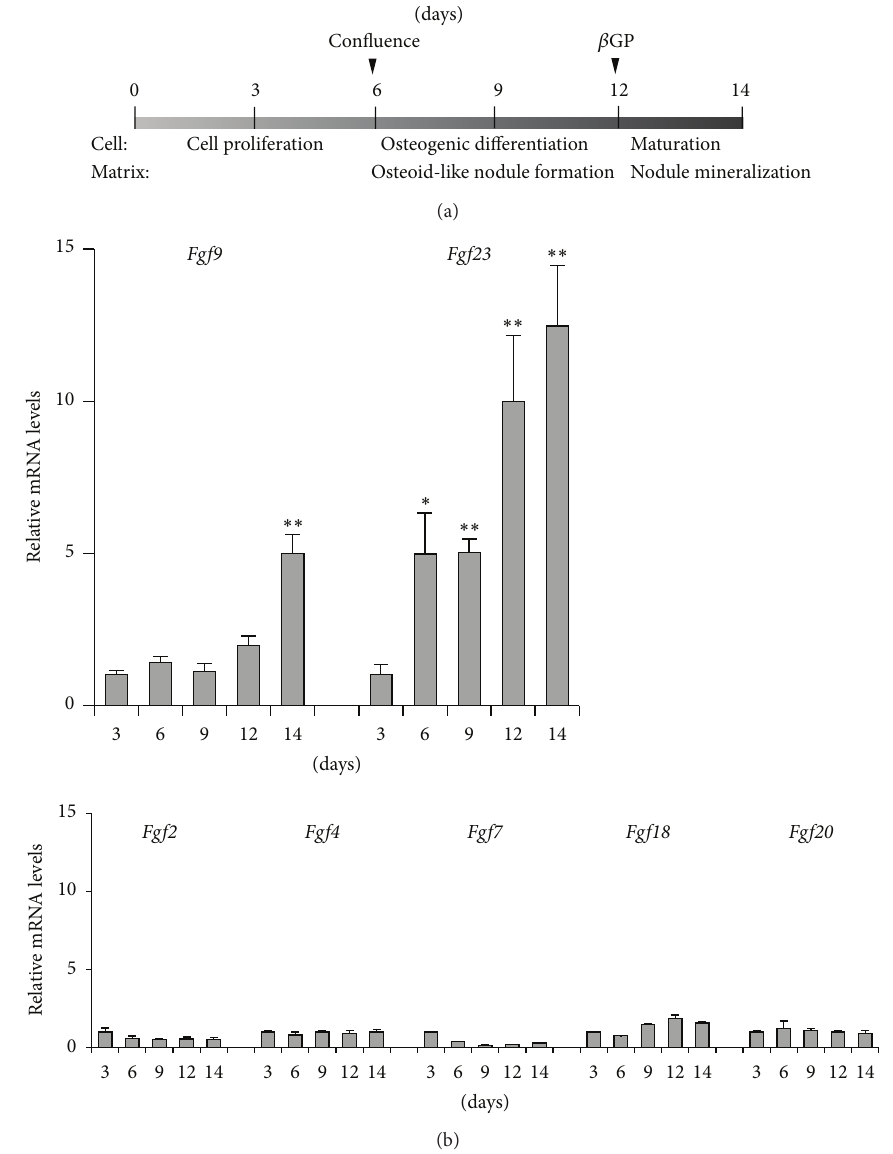
Figure 2: Expression profiling of Fgf genes in rat calvaria cell cultures. (a) Outline of osteoblast development. Rat calvaria cells from 21-day- old fetal rats [9] were plated at 3,000 cells per cm 2 and grown in 𝛼 MEM supplemented with 10% fetal calf serum plus 50 𝜇 g/mL ascorbic acid. Cells proliferate, reach confluence at day 6, and subsequently initiate osteoid-like nodule formation. To determine matrix mineralization, 10mM 𝛽 -glycerophosphate ( 𝛽 GP) is added to cultures for 2 days before culture termination. (b) Distinct gene expression patterns of Fgfs during osteoblast development. Total RNA was routinely prepared as indicated time points, and cDNA synthesis and quantitative real-time RT PCR (qPCR) were performed using standard protocols. Ribosomal protein L32 was used as internal control. Data represent means ± S.D. 𝑛 = 3 . Statistical significance of differences was analyzed with one-way or two-way analysis of variance (ANOVA) with repeated measures, followed by Tukey’s multiple comparison test. ∗ 𝑃 < 0.05 and ∗∗ 𝑃 < 0.01 versus day